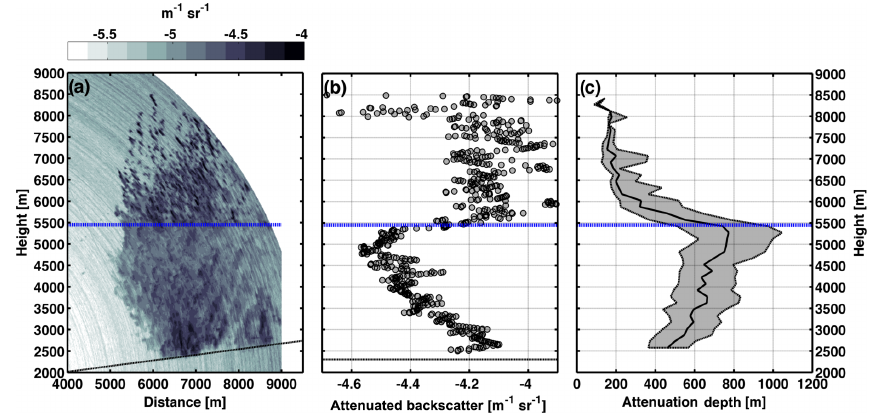
Figure 6. Statistical analysis of lidar data between 13:50 and 15:02PDT showing the plume condensation level. (a) Maximum backscatter as a function of height and distance. (b) Maximum backscatter as a function of height only. (c) 5, 50, and 95th percentiles of the attenuation depth as a function of height. The dashed blue line indicates the inferred condensation